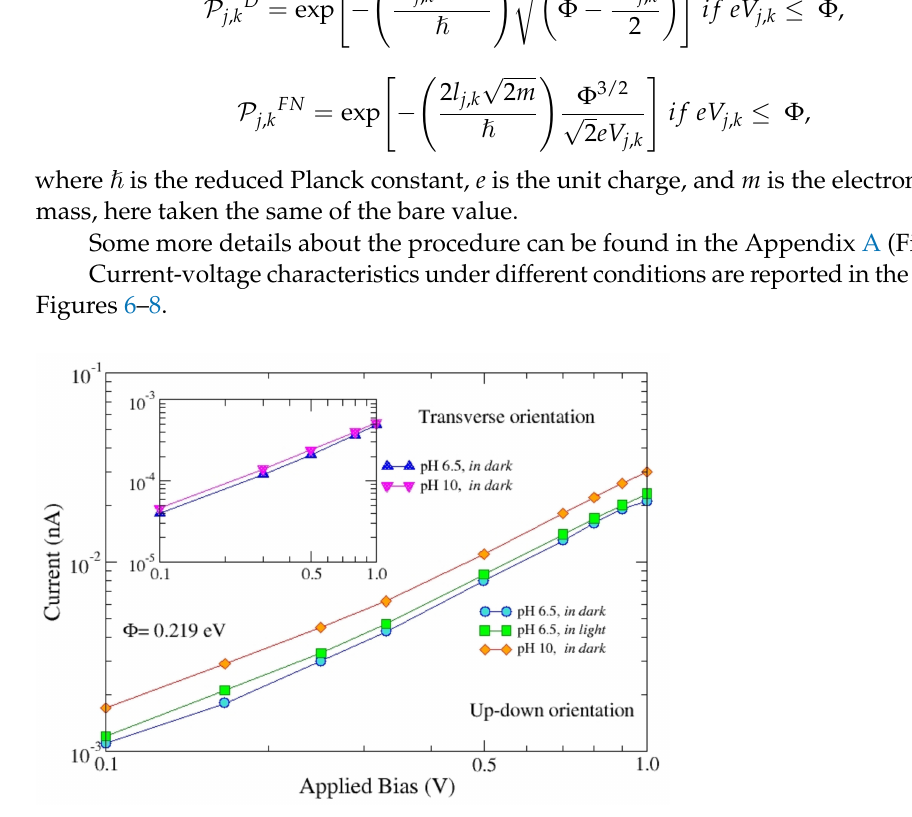
Figure 6. I - V characteristics of b RC in dark and in light within a range of applied bias of interest for experiments. The contacts are in the up-down orientation. Circles refer to results with the protein in dark at pH = 6.5, squares refer to the protein in light at pH = 6.5, diamonds refer to the protein in dark at pH = 10. In the inset the I - V I - V characteristics are for the protein in dark at pH = 6.5 (triangle up) and at pH = 10 (triangle down) using contacts in the transverse orientation. Lines are guides for the eye. Calculations make use of the following parameters: D = 10.5 Å, ρ max = 2.7 × 10 12 Ω Å, ρ min = 2.7 × 10 4 Ω Å, Φ = 0.219